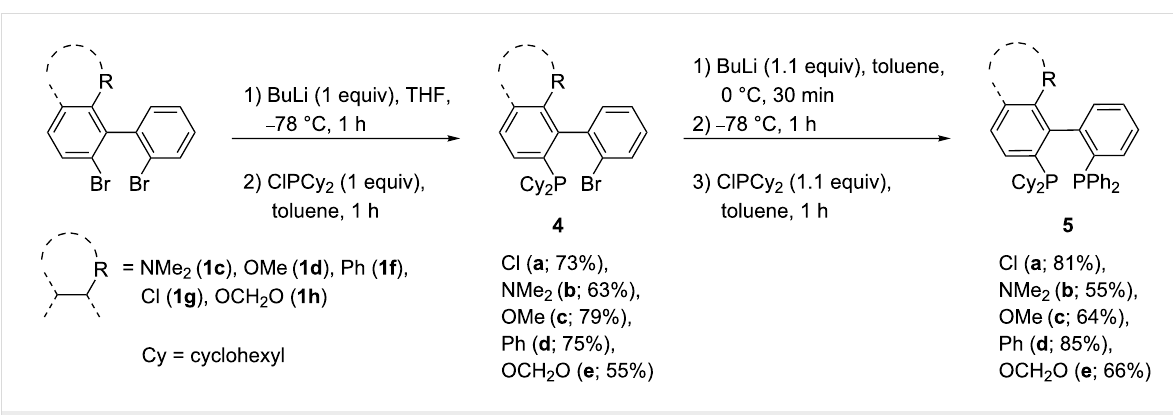
Scheme 4: Preparation of mixed dialkyl(diaryl)phosphinobiphenyls 5 via successive bromine–lithium